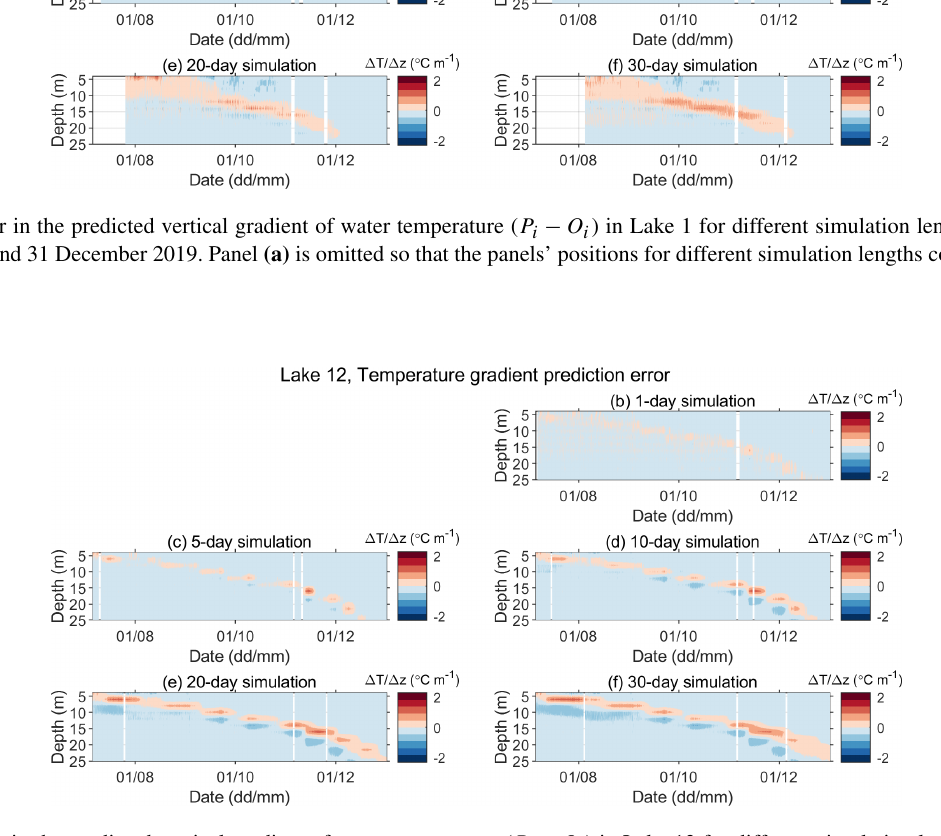
Figure A6. Error in the predicted vertical gradient of water temperature ( P i − O i ) in Lake 12 for different simulation lengths in the period between 6 July and 31 December 2019. Panel (a) is omitted so that the panels’ positions for different simulation lengths correspond to those in Fig.